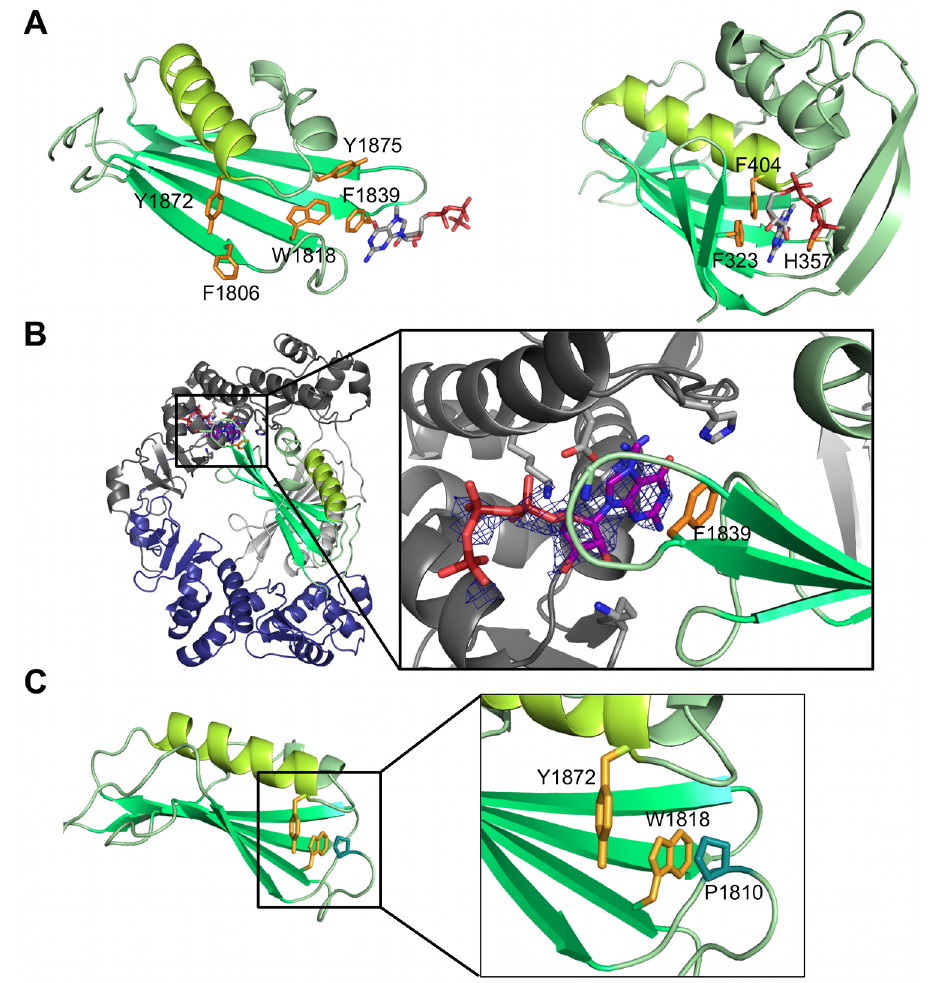
Fig 4. Examination of CASV L-Cterm cap-binding in comparison to influenza virus PB2. A) Comparison of CASV L-Cterm domain2 (left panel)with PB2 cap-bindingdomain(PDB ID 2VQZ, right panel) with structures presented as ribbondiagrams. Structurally similar elementshave the same color. Potential cap-binding aromatic residues in CASV L-Cterm and actual cap-bindingresiduesin PB2 are shownas sticks and coloredin orange. Bound m 7 GTP moleculesare shown as sticks. B) The figure shows bindingof m 7 GTP to the CASV L-Cterm dimer in the crystal after soakingexperiments. An overview(left) and close-up (right) are shown. CASV L-Cterm is presented as a ribbondiagram with the residuesrelevant for bindingshown as sticks. m 7 GTP is shown as sticks and the surroundingelectrondensity (2|Fo|-|Fc| map at 2 σ ) as blue mesh. C) Interaction of W1818 with P1810 from a neighboring loop. CASV L-Cterm domain 2 is shownas green ribbondiagram, potentialcap-bindingresidueY1872 and W1818 are shown as orangesticks, and P1810 as blue